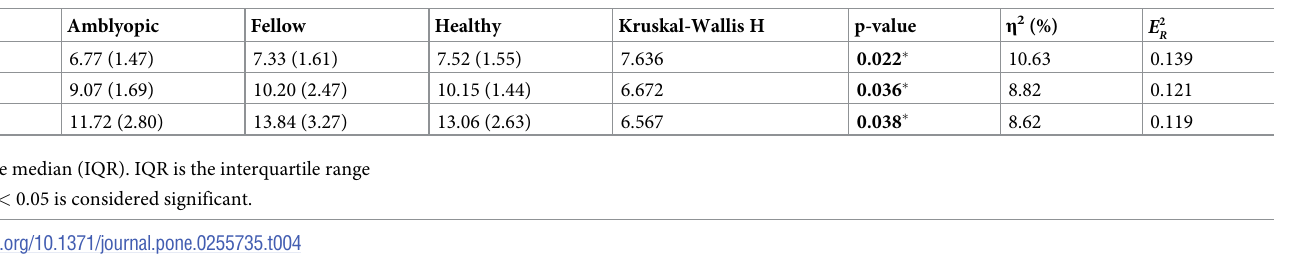
Table 4. Comparison of the reflectivity of the ROIs#4, 5, and 8 among amblyopic, fellow, and healthy eyes. Amblyopic Fellow Healthy